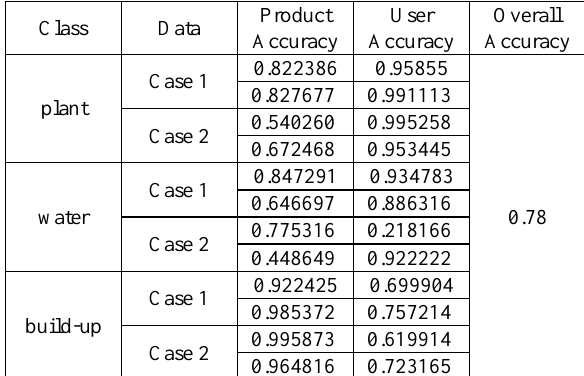
Table 3 Accuracy of Single-scale CART